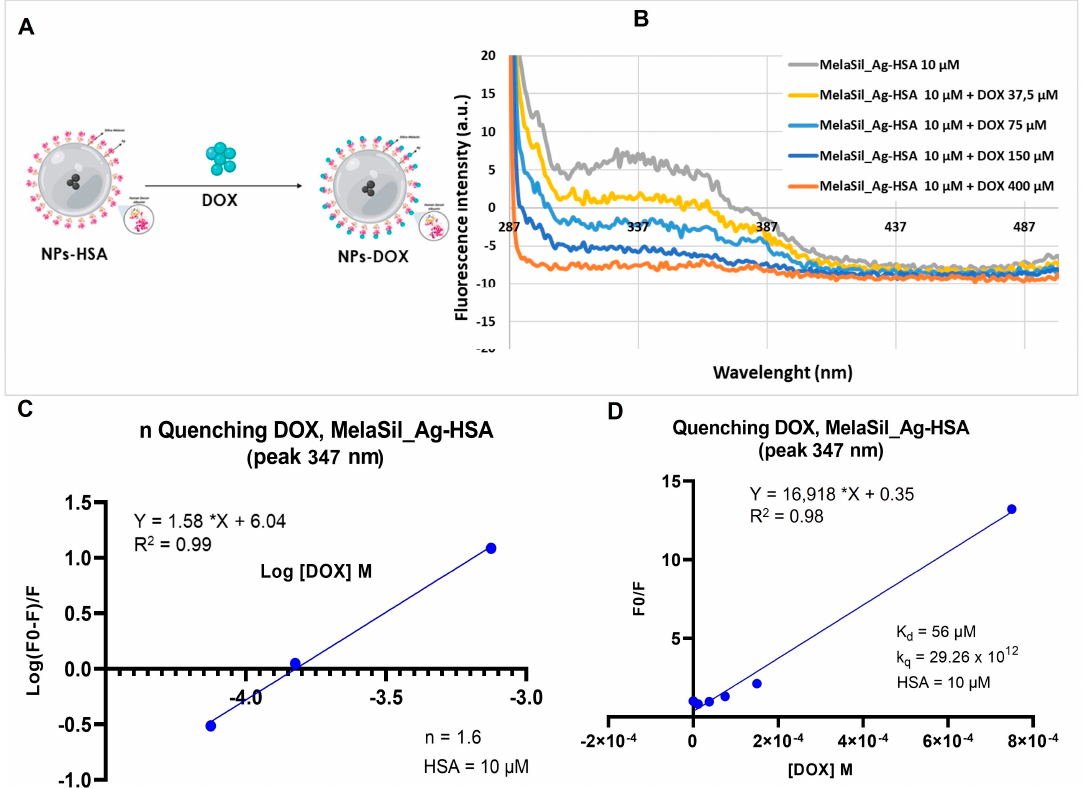
Figure 2. Fluorescence emission spectra and Stern–Volmer plots for MelaSil_Ag-HSA NPs—doxorubicin interaction. ( A ) DOX loading scheme; ( B ) fluorescence emission spectra; ( C ) Stern–Volmer plot of HSA binding sites; ( D ) Stern–Volmer plot of K d and k q . p < 0.05.